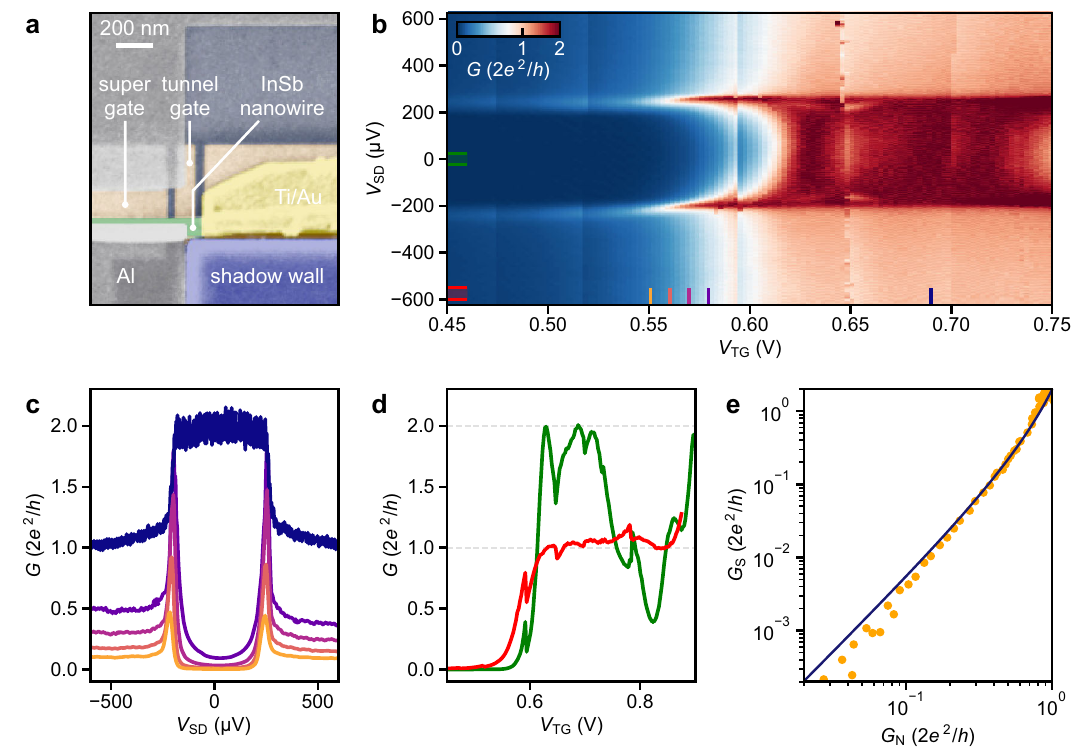
Fig. 4 Ballistic Andreev transport. a False-colour SEM image of an exemplary N – S junction. The W bottom gates (brown) underneath the 100-nm-wide InSb nanowire (green) are covered by 18 nm of Al 2 O 3 dielectric. b Differential conductance, G , as a function of source – drain voltage, V SD , and bottom tunnel-gate voltage, V TG . The so-called super gate, which controls the chemical potential of the hybrid nanowire segment, is grounded. c G versus V SD line- cuts of the data in panel b at the locations designated by the coloured lines. d Subgap conductance (green) and above-gap conductance (red) averaged over the V SD intervals designated in panel b . e G S (subgap conductance at zero bias) as a function of G N (normal-state conductance at V SD = 650 μ V) together with the theoretically predicted dependence, which assumes Andreev-dominated transport in a single channel (blue line